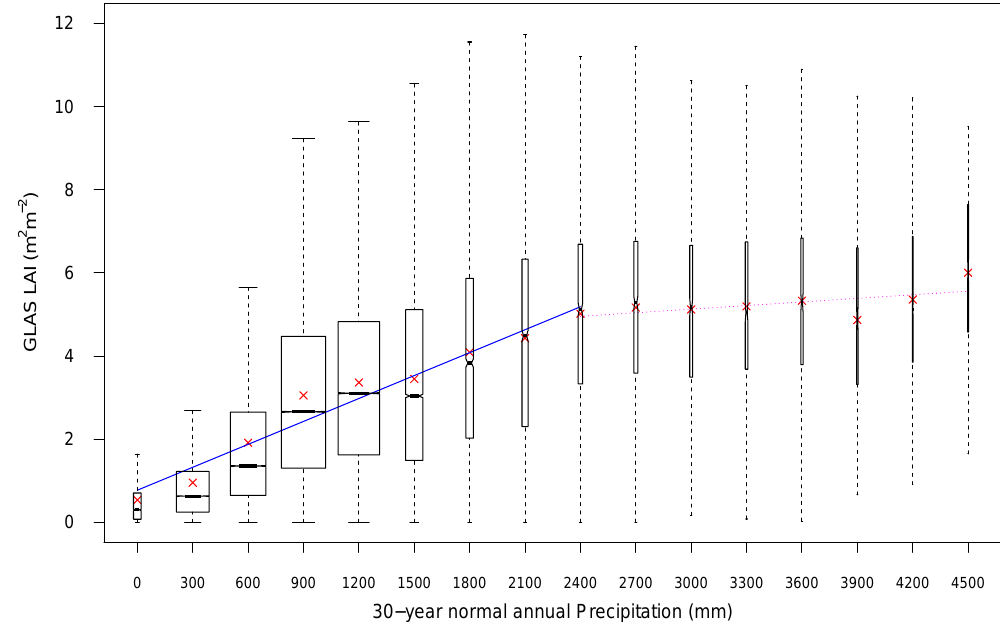
Figure 10. Distribution of GLAS LAI as a function of precipitation. A linear regression analysis of LAI values averaged by precipitation groups shows an increasing trend up to areas of about 2400mm (blue line). Beyond this value the rate of change slows considerably (magenta line), but the trend is only weakly significant ( P =